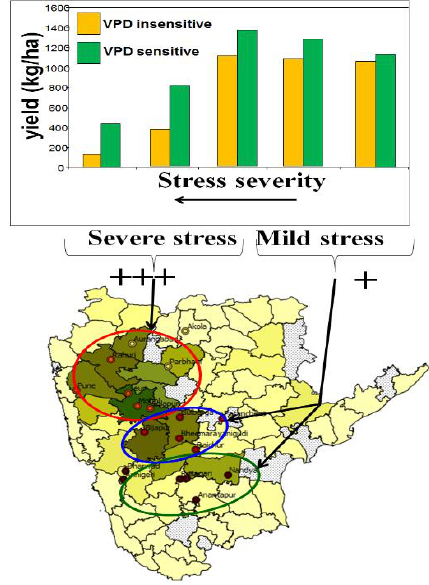
Figure 7. Crop modelling predictions of trait alterations on yield (top chart) in different stress scenarios of a large sorghum growing area in India (bottom map). The top graph shows APSIM predictions of grain yield across five stressed environments in a standard genotype that is insensitive to vapour pressure deficit (VPD; orange bars) and in the same genotype when made sensitive to VPD (green bars). The bottom map shows the areas where introgression of the VPD-sensitivity trait would have the strongest effect (based on the frequency of different stress scenarios in the growing regions), i.e., more in the northern sub-region where the prevalence of severe stress is higher, less so in the two southern sub-regions where the prevalence of mild stress is higher. Adapted from Kholova et al. [151].